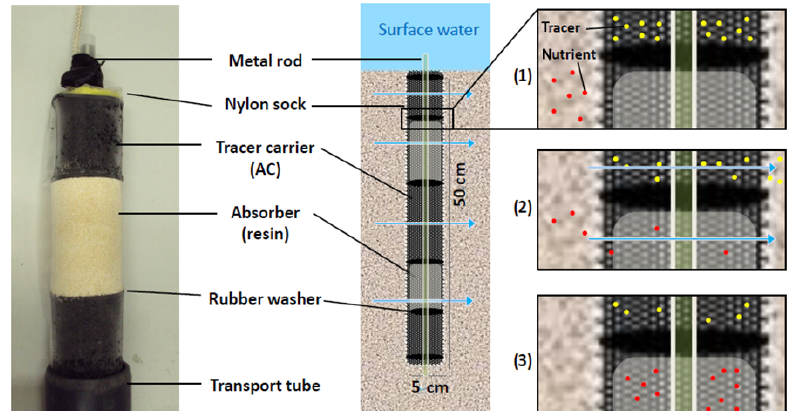
Figure 1. Photograph of an HPFM with alternating segments before deployment (left), schematic profile of a deployed HPFM (middle) and schematic steps of HPFM functioning (right): (1) directly after installation, tracer resides on activated carbon (AC), (2) infiltrating water washes out the tracer, nutrients enter the HPFM and are absorbed on the resin, (3) after retrieval nutrients are fixed on the resin, tracer concentration is